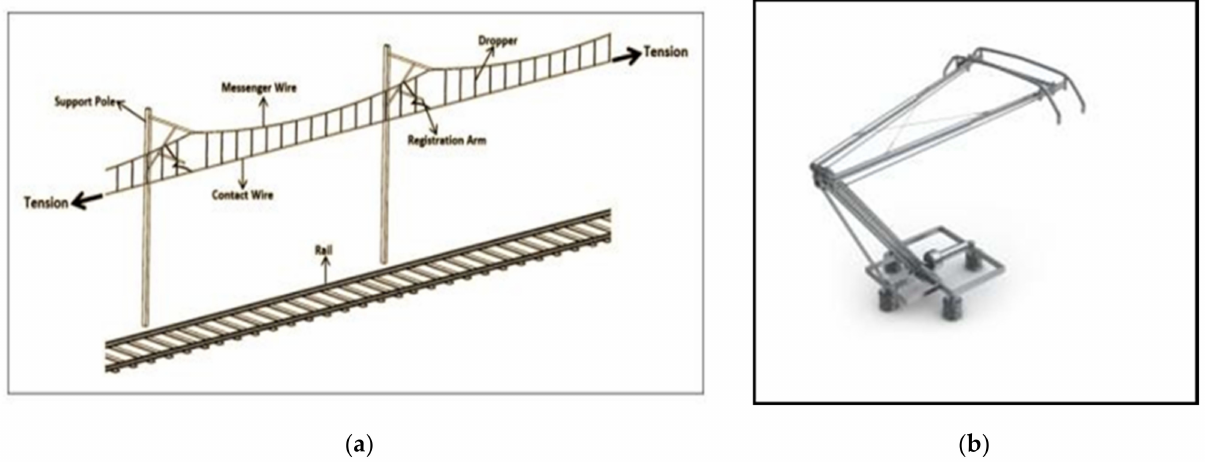
Figure 1. Overhead contact line ( a ) and ( b ).typical pantograph ( source Faiveley ). Current is collected from the CW by roof mounted devices on the trains, known as pantographs. A pantograph consists of a head carrying a number of carbon collector strips, supported on an articulated frame, which will accommodate variations in height of the pantograph head, whilst maintaining a constant attitude (Figure 1b). An uplift force is applied by the pantograph to the head by air pressure or springs, typically of around 70–120